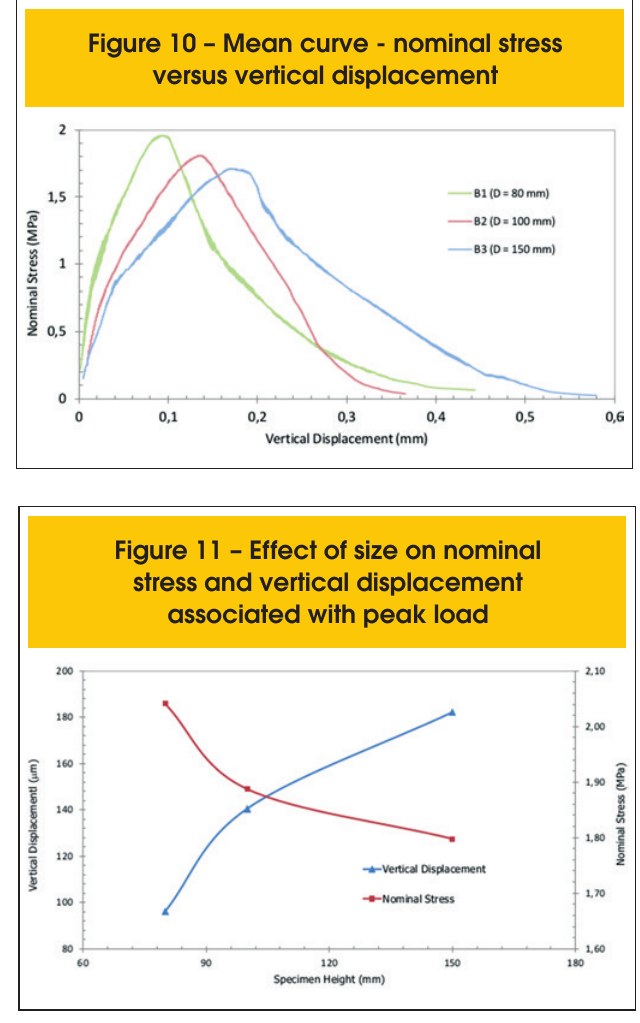
Figure 10 – Mean curve - nominal stress versus vertical displacement